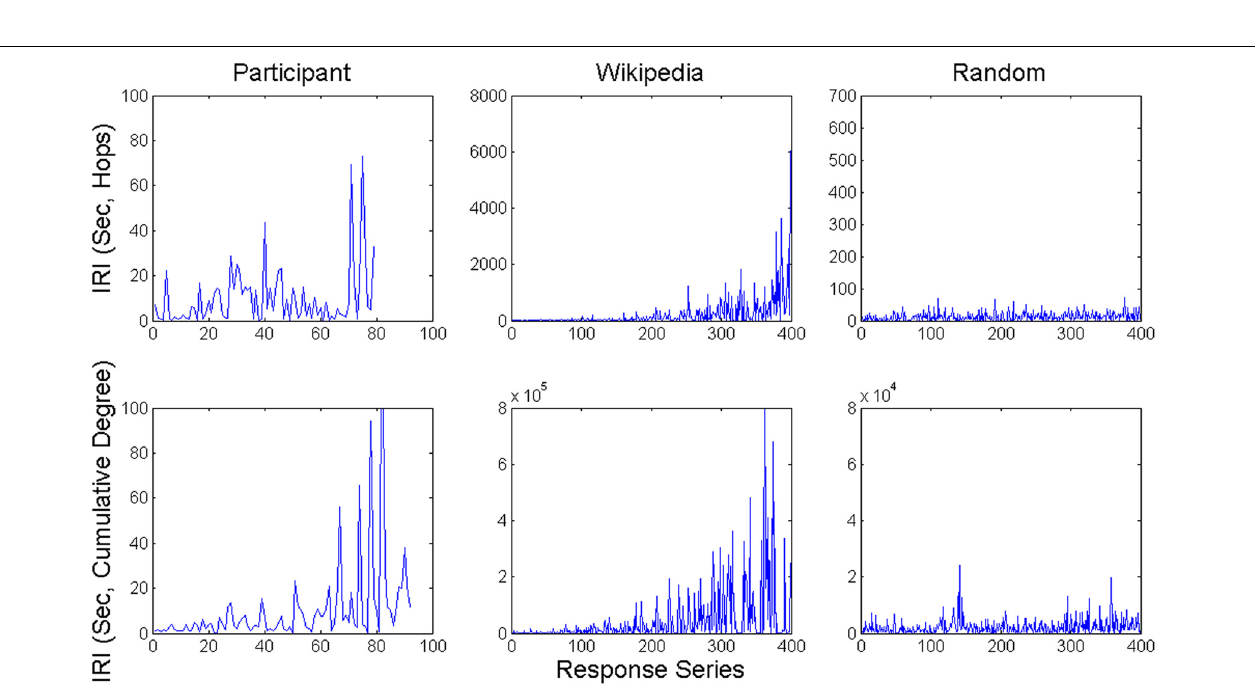
FIGURE 3 | Example time series of IRI’s from a participant in the category generation task and network walker model runs over both the Wikipedia animal network and scrambled control network.